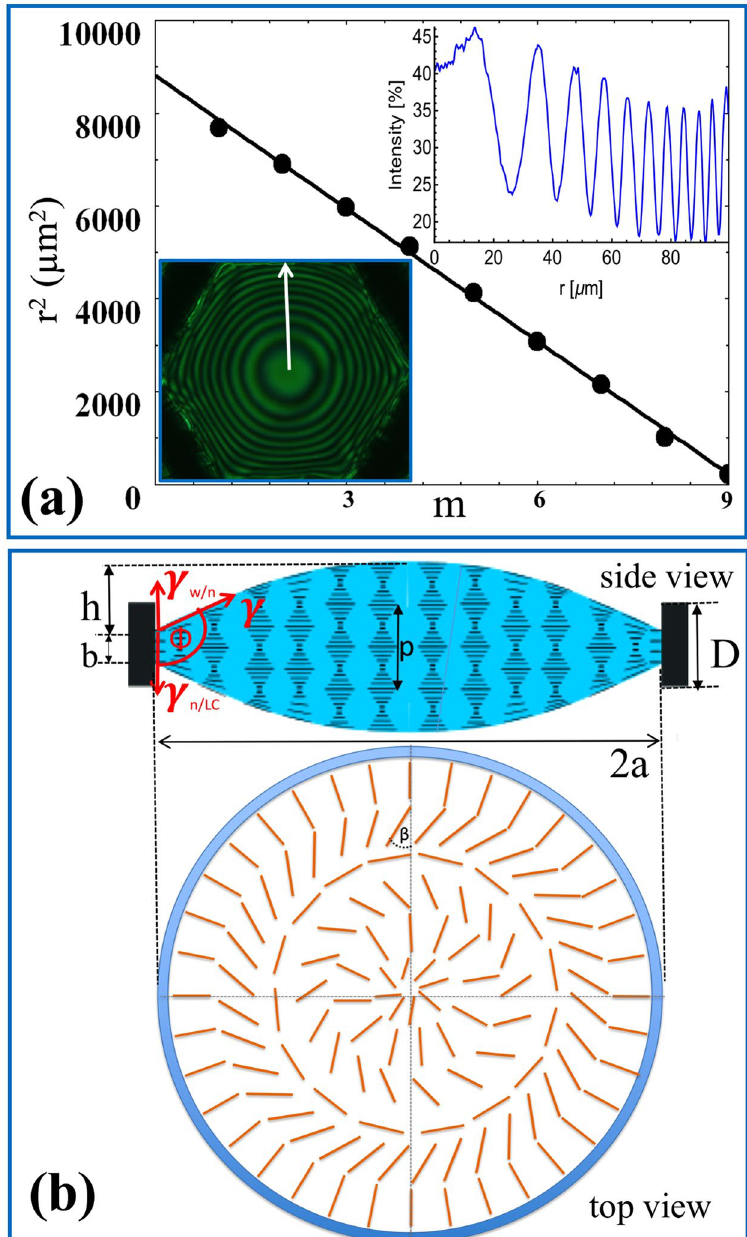
Figure 4. Analysis of the height profile of an N * LC microlens: ( a ) Plot of the square of the position of the minima with respect to their number, with m = 1 corresponding to the outermost ring. The linear dependence shows that the height profile is spherical. The lower inset shows the microlens viewed using a pair of circular polarizers and a green filter λ = 0.55 ± 0.02 μ m . The length of the white arrow is 100 μ m . The upper inset shows the intensity profile along the white arrow; ( b ) Cartoons of the directors within the cell: the upper images shows the cross sectional profile with relevant geometric and surface tension parameters, while the lower image shows the top view of the director